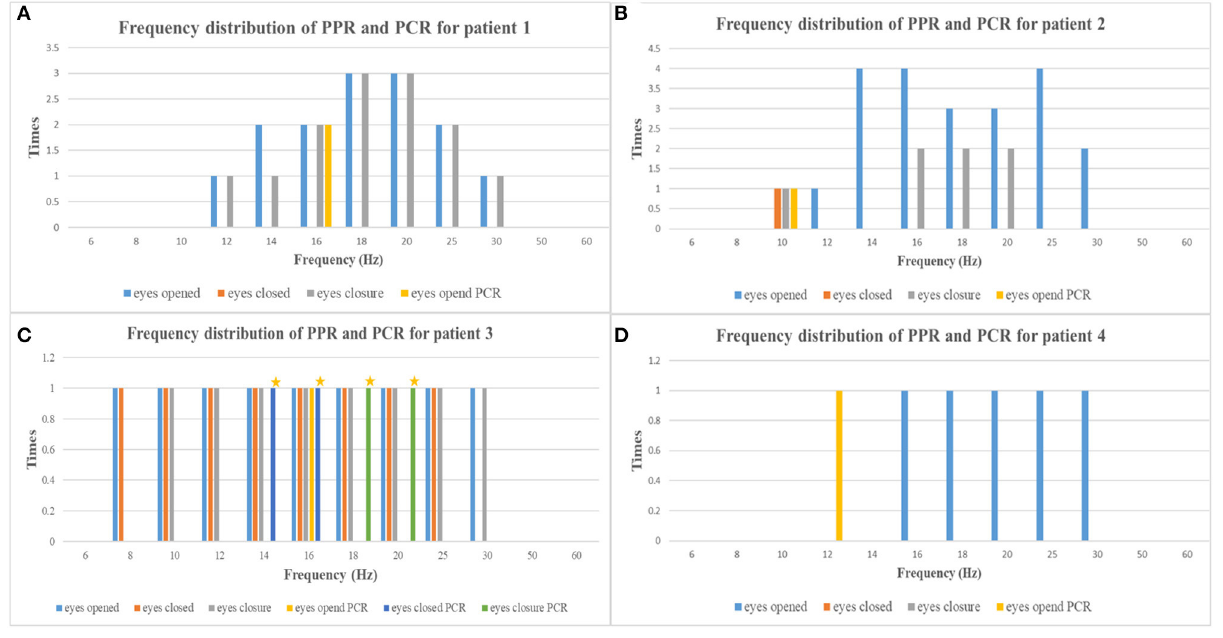
FIGURE 1 | The frequency distribution of PPR and PCR of each patient [ (A) patient 1, (B) patient 2, (C) patient 3, (D) patient 4; yellow asterisks, myoclonic seizures] (PPR, photoparoxysmal response; PCR, photoconvulsive